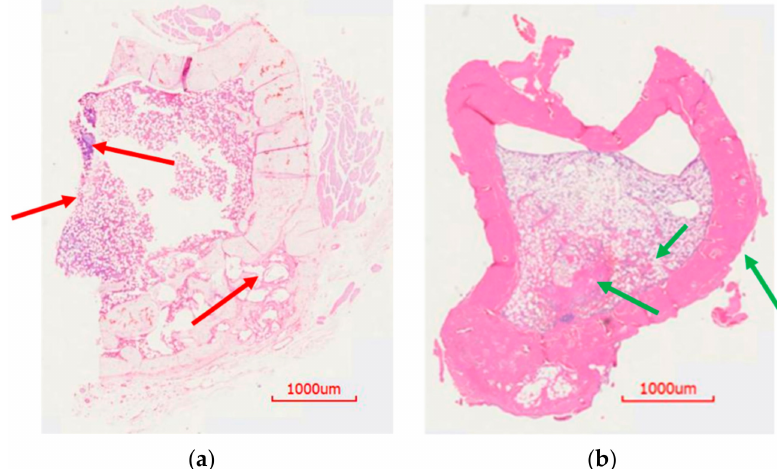
Figure 8. H&E staining of rat bones from drill-hole model. ( a ) H&E staining of control rat bone. There was a lack of bone growth at the dilled site. There was some destruction of the bone. ( b ) Bone from treatment group rat showed healing of the bone and cortical bridging with new bone growth.